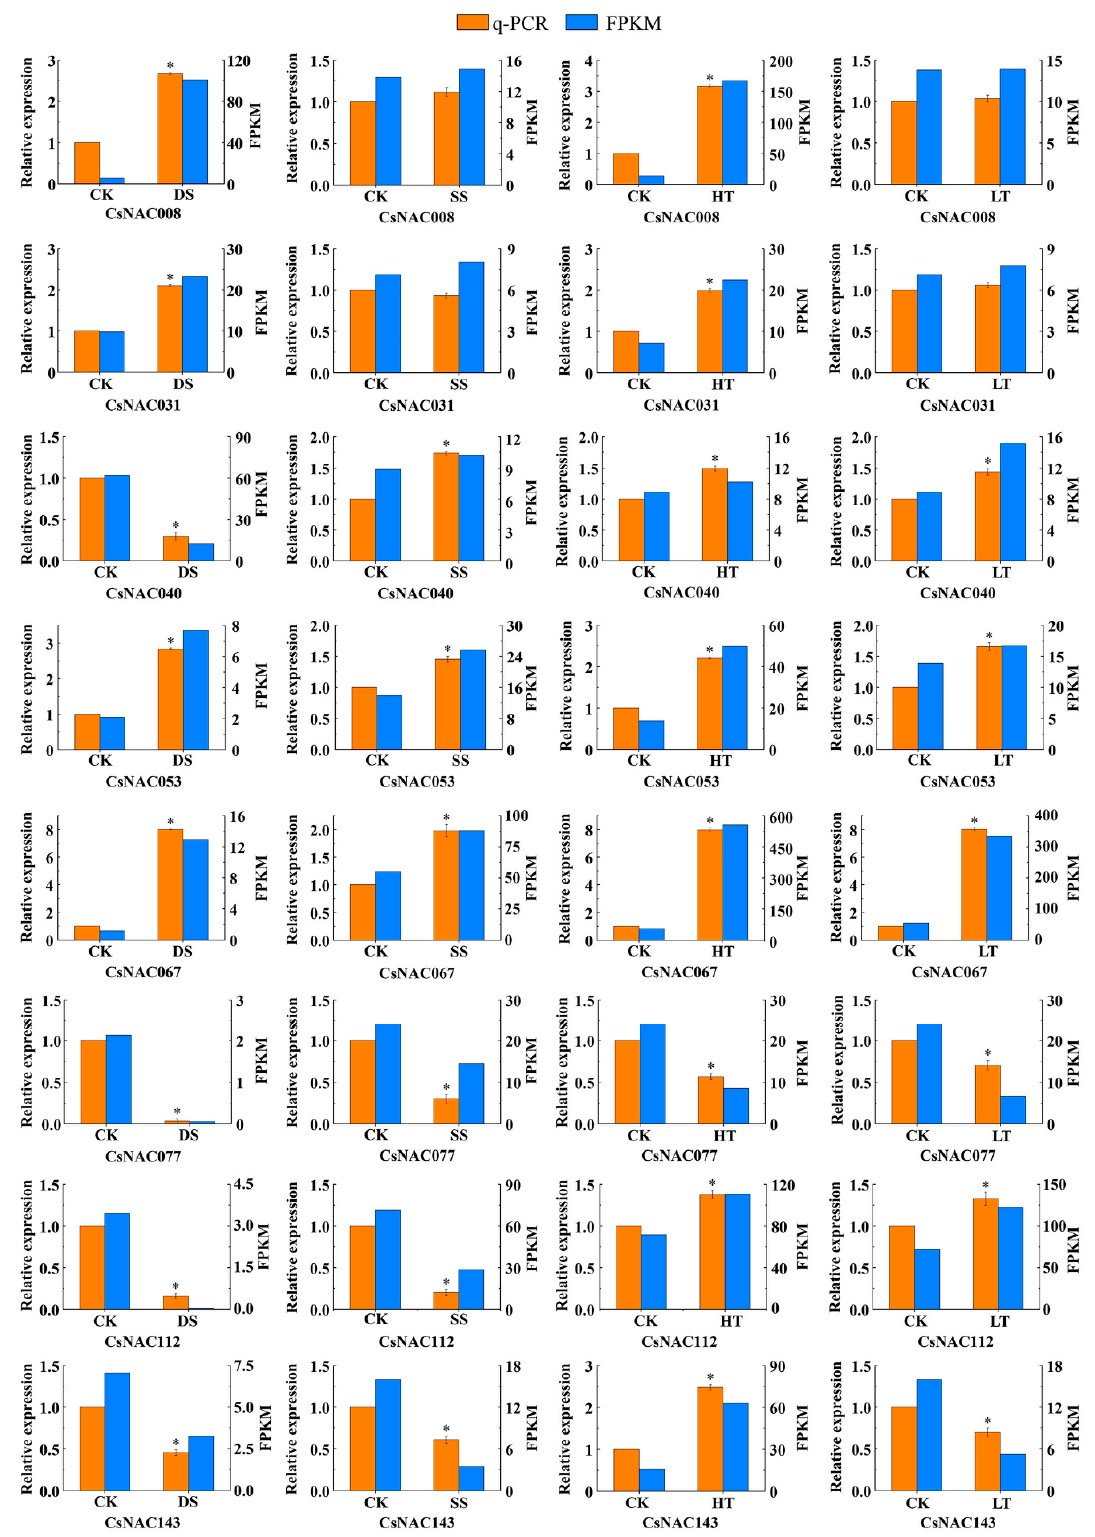
Figure 9. The expression of selected CsNAC genes under abiotic stress in shoots by qRT-PCR. DS: drought stress; SS: salt stress; HT: high temperature; LT: low temperature. Bars represent means ± standard error ( n = 3). Asterisks indicate relative expression significant differences under abiotic stress ( p < 0.05). The CsGAPDH was used as the internal control.